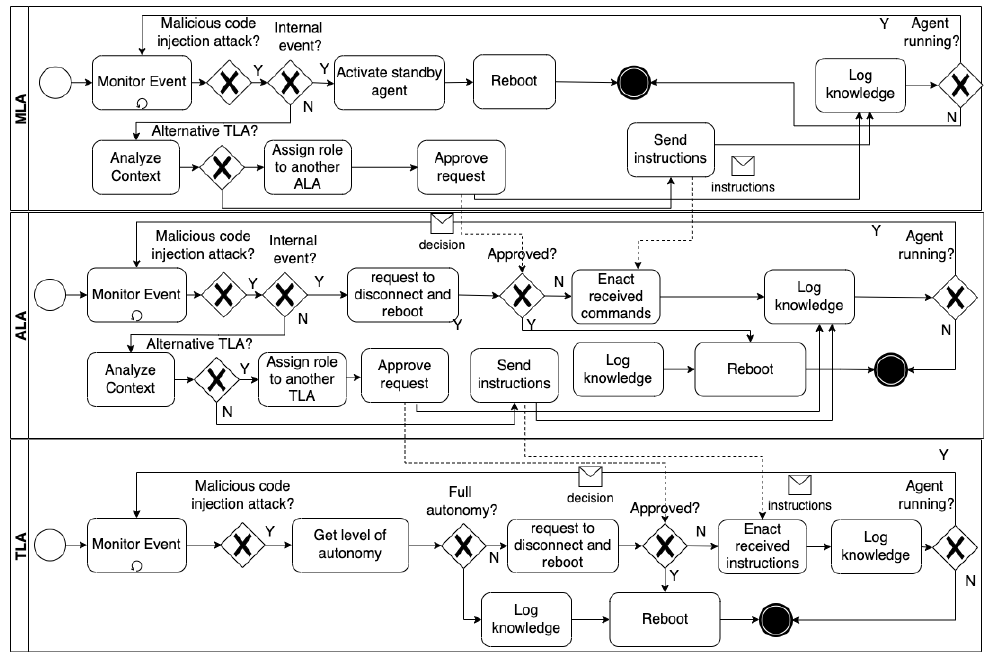
Figure 8. The adaptation process to a malicious code-injection attack.